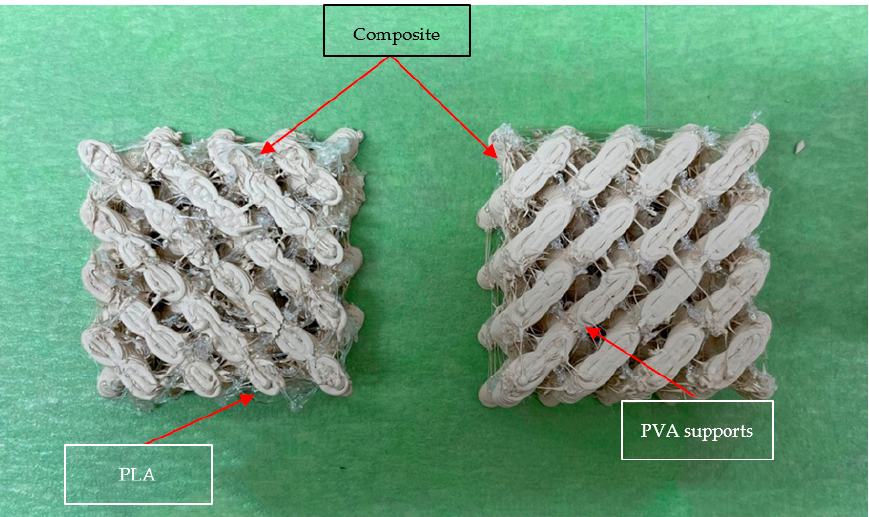
Figure 11. Partial print with PLA support structures ( left ) and PVA ( right ).